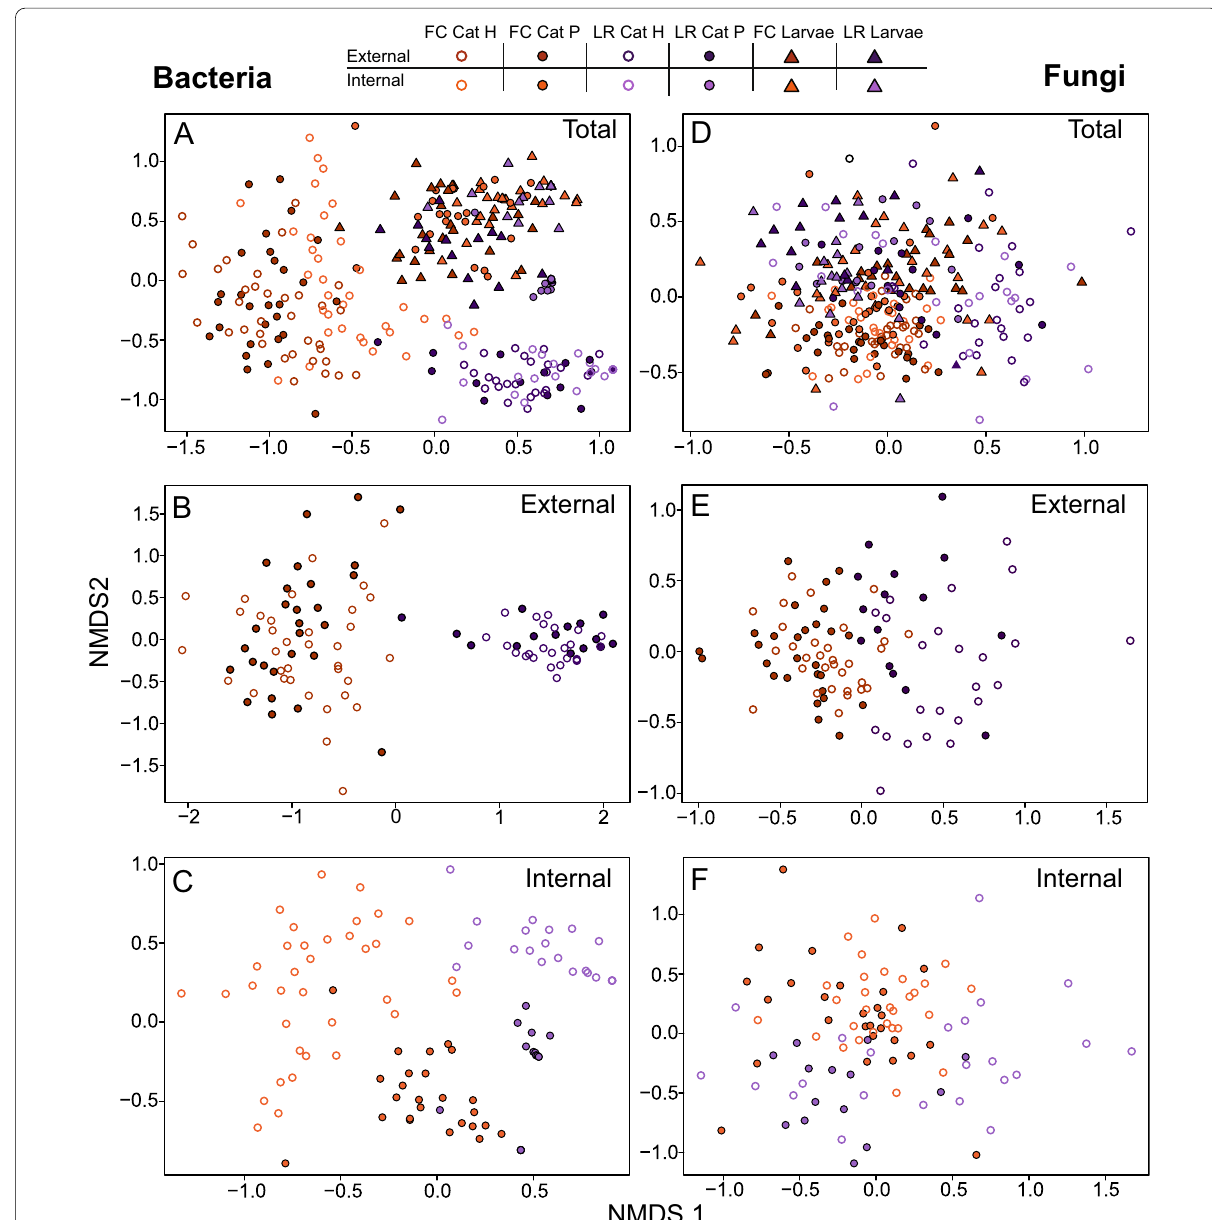
Fig. 2 Non-metric multidimensional scaling (NMDS) ordination plots based on Bray–Curtis distances of Hellinger-transformed relative abundance data of the bacterial ( A – C ) and fungal communities ( D – F ) of the different caterpillars ( Pieris brassicae ) and parasitoid larvae ( Cotesia glomerata ) samples studied. Results for all samples are shown in A (stress 0.181) and D (stress 0.282). Results for the external samples are shown in B = = (stress 0.170) and E (stress 0.239), and for the internal samples in C (stress 0.181) and F (stress 0.266). Abbreviations used: Cat = = = = H healthy; P parasitized; FC field-collected; and LR = = = =